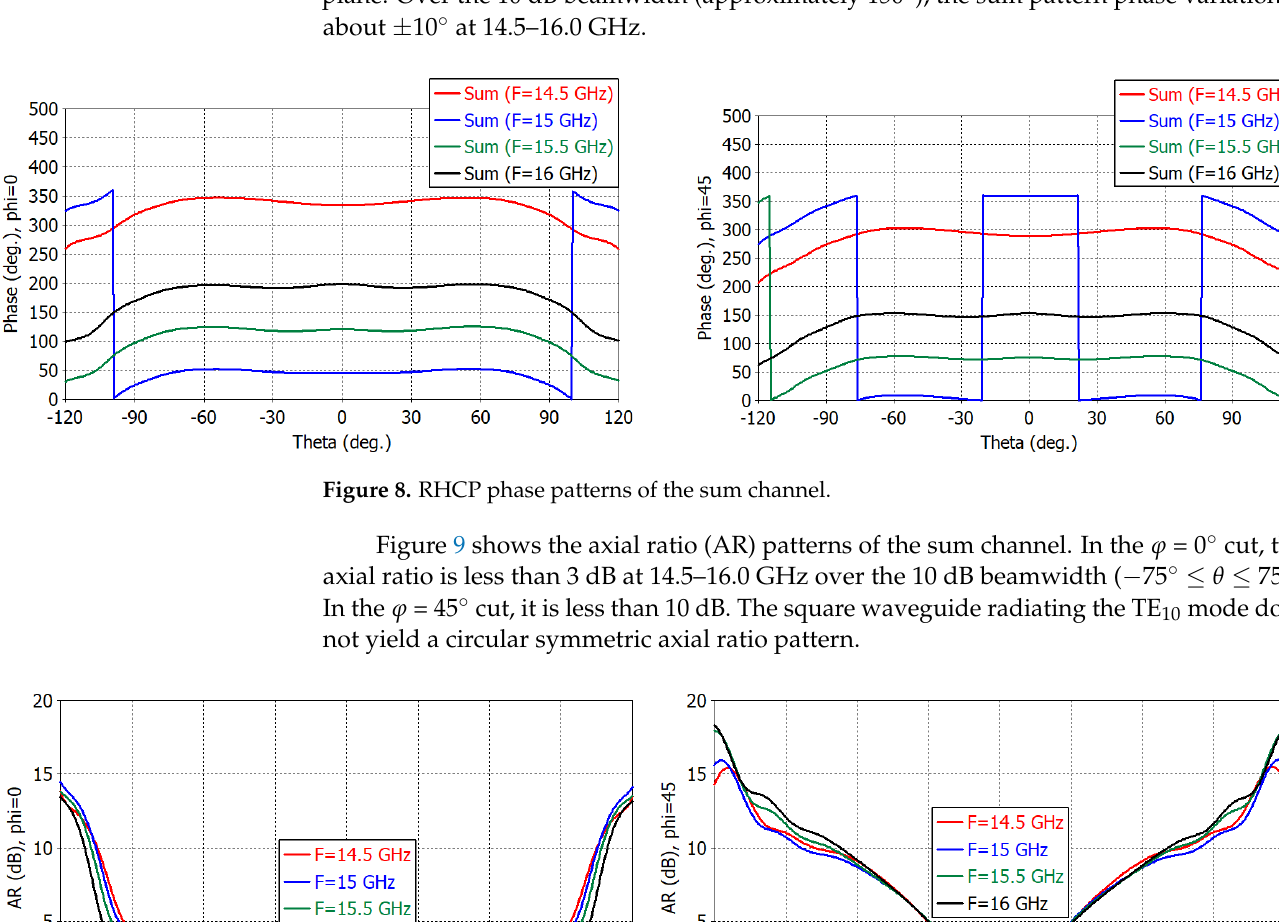
Figure 9. RHCP axial ratio patterns of the sum channel.